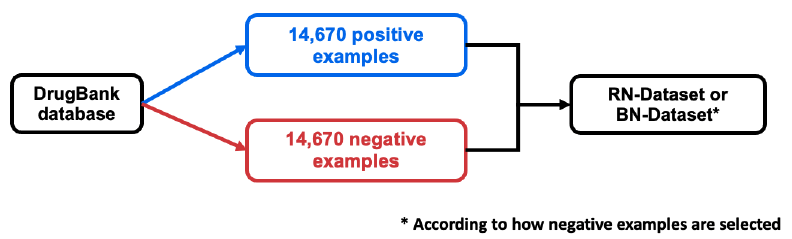
Figure 1. Method for building one RN-dataset (or one